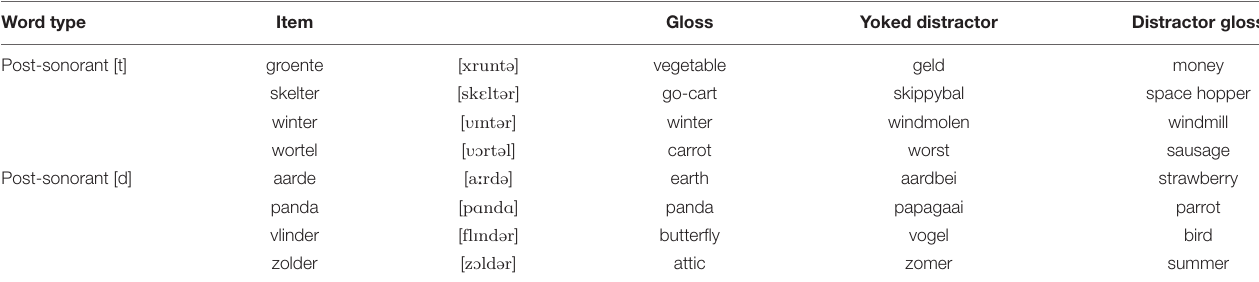
TABLE 5 | Monomorphemic target items used in Experiment 2 and yoked distractor